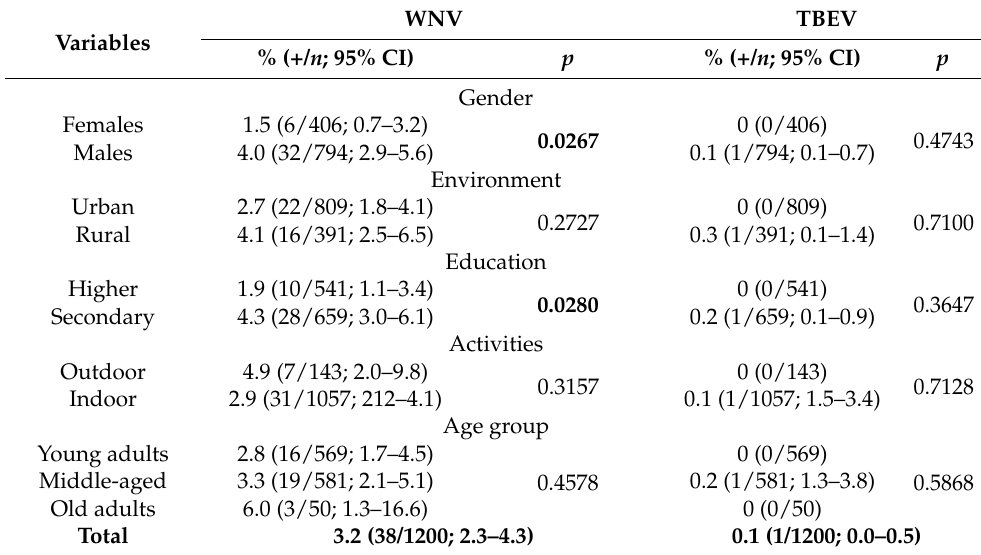
Table 3. WNV and TBEV seroprevalence by SNT according to gender, environment, education level, activities, and age group category.